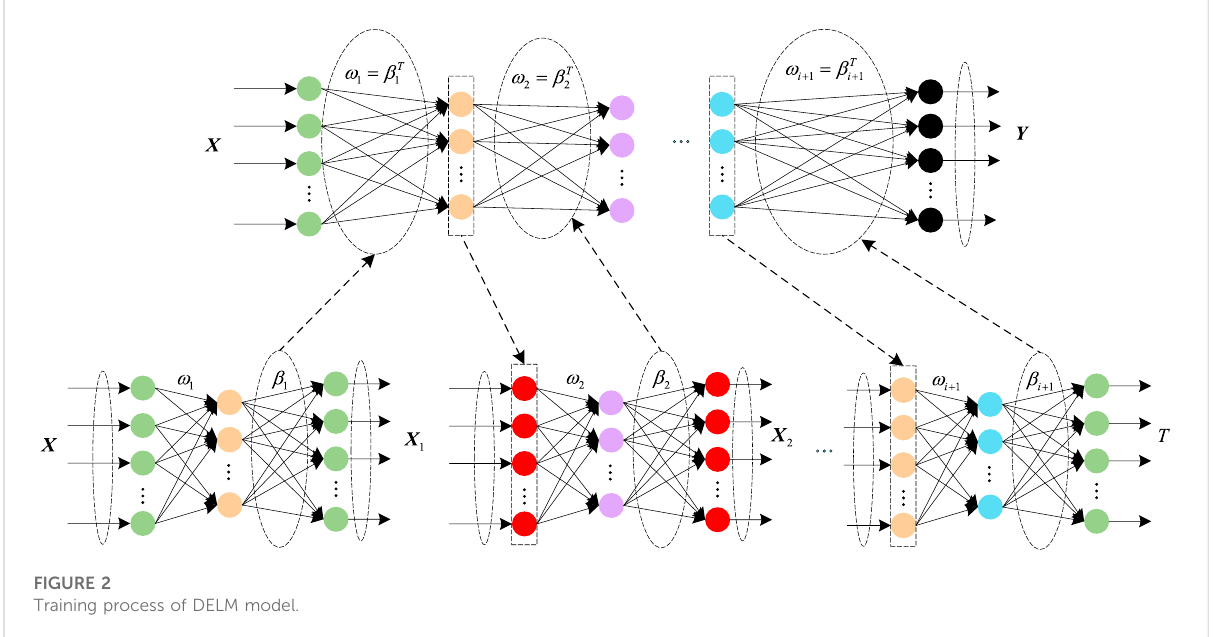
FIGURE 2 Training process of DELM